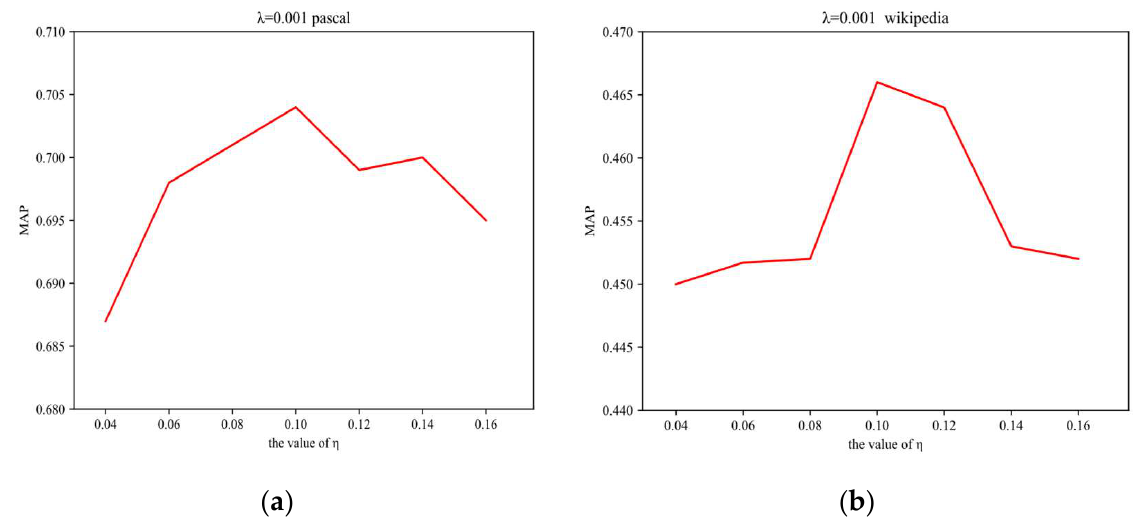
Figure 7. The cross-modal retrieval performances with different η values. ( a ) The cross-modal re- trieval performances with different η values and λ = 0.001 on the Pascal Sentence dataset. ( b ) The cross-modal retrieval performances with different η values and λ = 0.001 on the Wikipedia dataset.